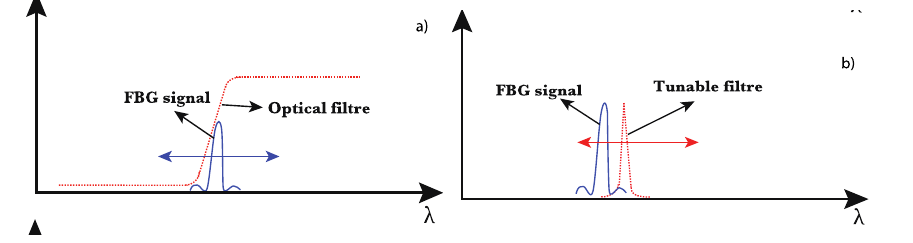
Figure 6. Operating principle of the edge filter ( a ) and tunable filter ( b )